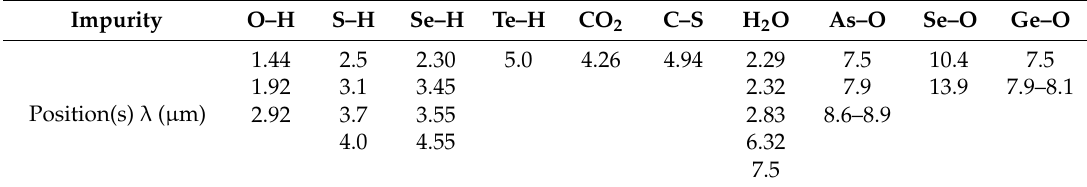
Table 1. Mid-infrared signatures of the impurity absorption bands in chalcogenide fibers [150,152,153].